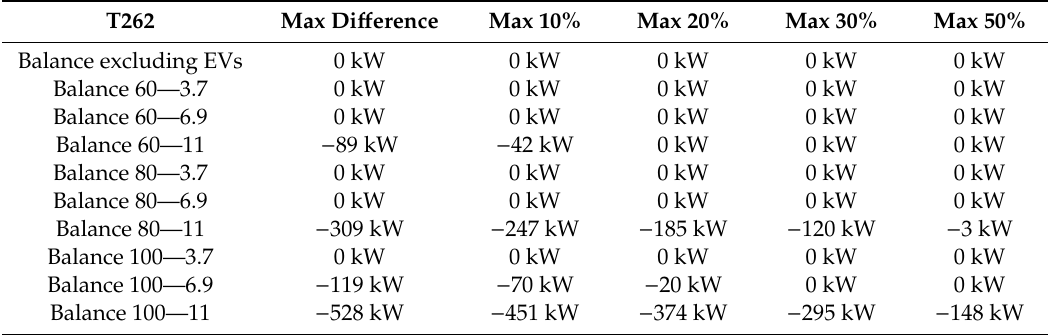
Table 16. Replacement of electric heating by district heating in the presence of flexible demand for transformer T262—Charging at night.